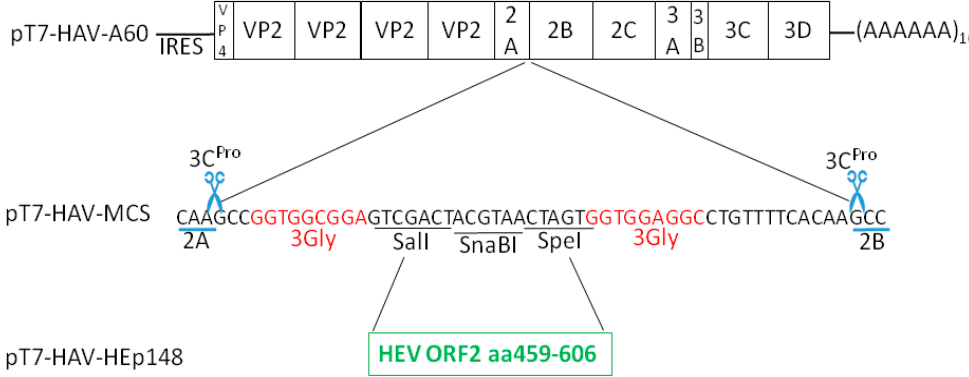
Figure 1. Schematic representation of hepatitis A virus-HEV neutralization epitope (HAV-HEp148) constructs containing the HEp148 protein in the 2A/2B junction of HAV. The HEp148 gene was cloned into the 2A/2B junction of the HAV genome in the pT7-HAV-A60-MCS (multiple cloning site). This plasmid contains a polylinker coding for restriction sites (SalI, SnaBI, and SpeI) flanked by 3Gly hinges (red color letters), and HAV 3Cpro cleavage sites (scissors) engineered into the 2A/2B junction of pT7-HAV-A60. The HEp148 gene coding for the hepatitis E virus (HEV) neutralization epitope was cloned into the SalI and SpeI sites of pT7-HAV-A60-MCS, and the resulting plasmid was termed pT7-HAV-HEp148.